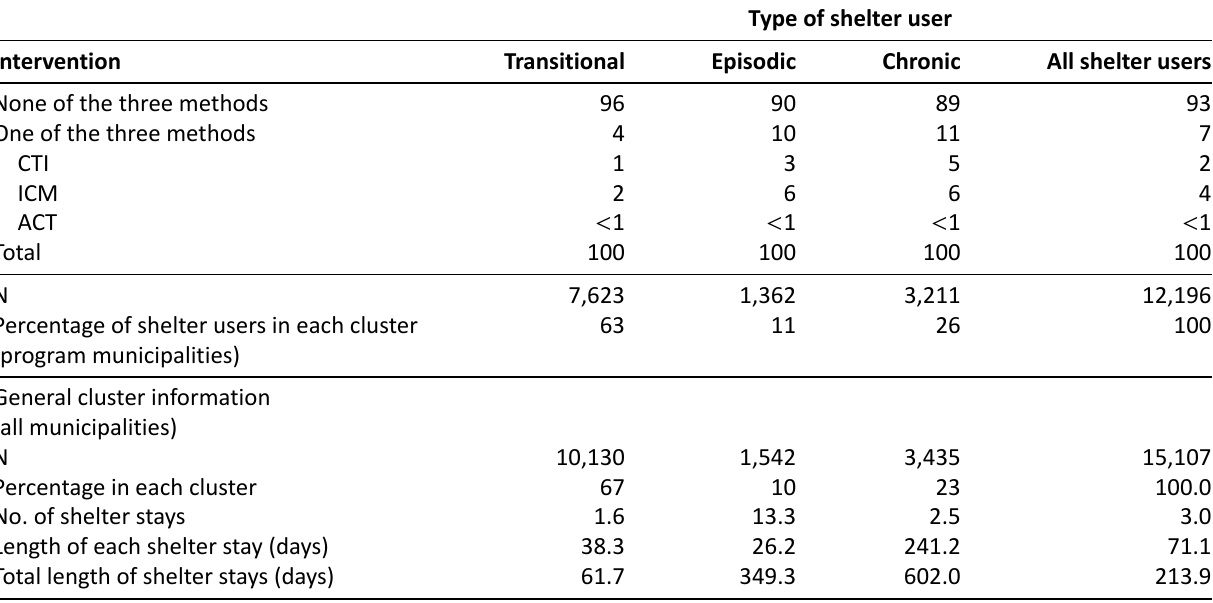
Table 2. Proportion of transitional, episodic, and chronic shelter users receiving CTI-, ICM- or ACT-support from the Hous- ing First program under the homelessness strategy program or the follow-up program. Source: Benjaminsen and Enemark (2017, pp. 75,